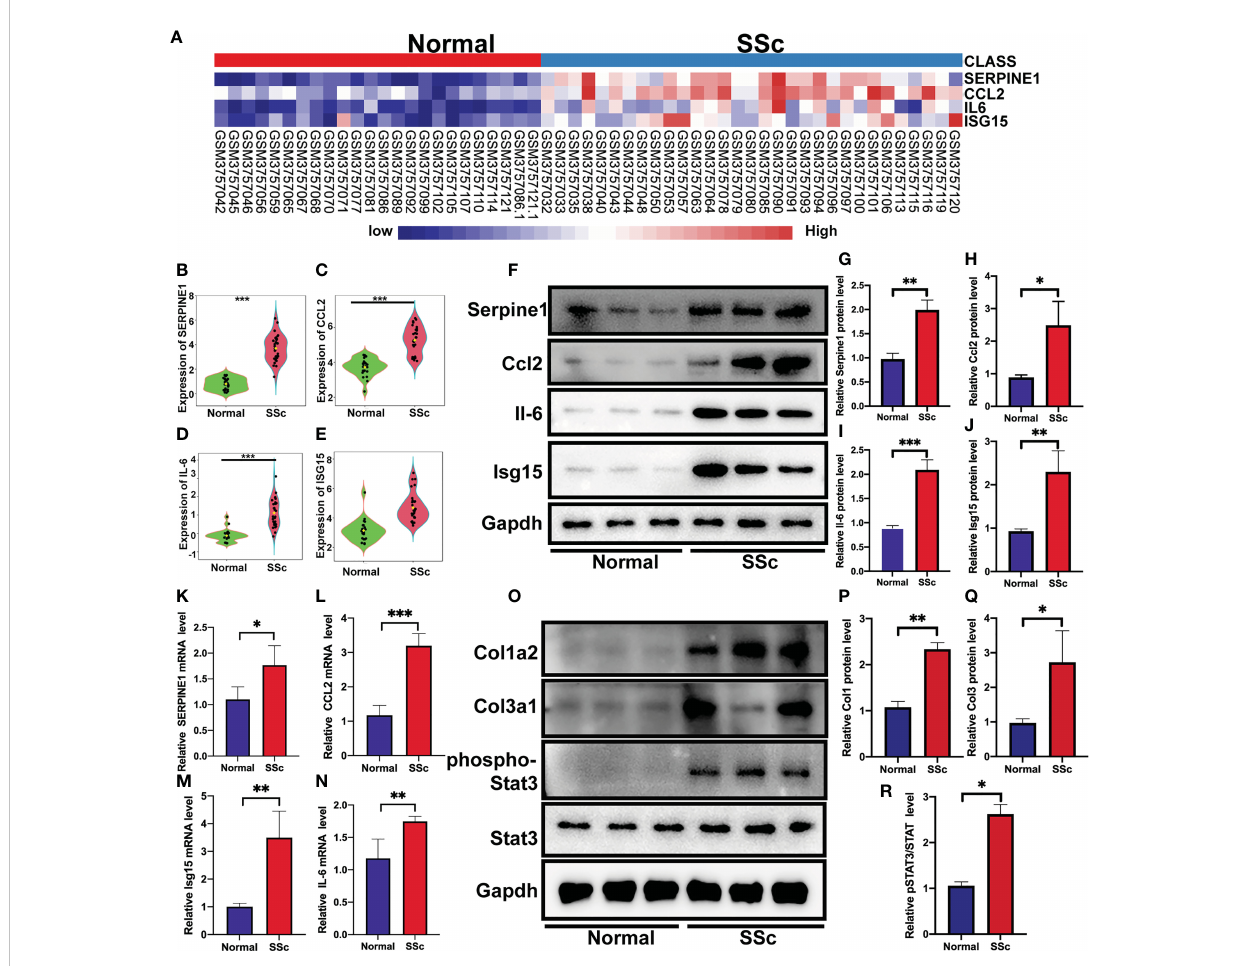
FIGURE 4 Veri fi cation of the 4 speci fi cally expressed hub genes. (A) The heatmap showed the expression of four tissue-speci fi cally expressed hub genes using the validation dataset. (B-E) The violin plot showed the detailed expression of four tissue-speci fi c expressed hub genes using validation dataset. (F-J) Western blot showed the protein expression of Serpine1, Ccl2, Isg15 and Il6 in mouse skin tissue. (K-N) Quanti fi cation of Serpine1, Ccl2, Isg15 and Il6 mRNA in mouse skin tissue. (O – R) Western blot showed the protein expression of Col1a2, Col3a1, phospho-STAT3, and STAT3 in mouse skin tissue. *P < 0.05; **P < 0.01; ***P <